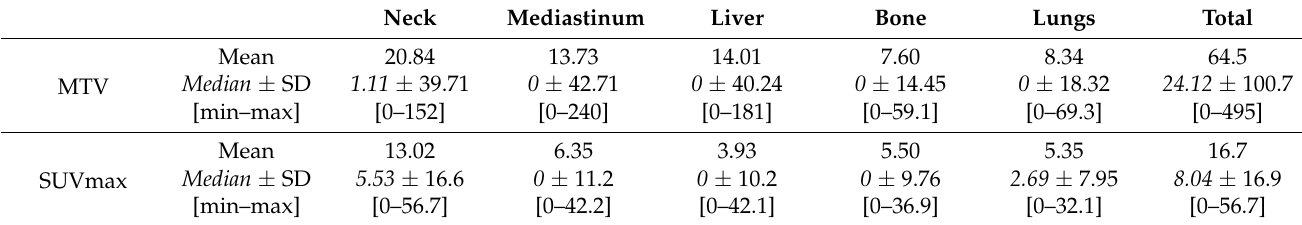
Table 2. Description of PET metrics on diagnostic 18